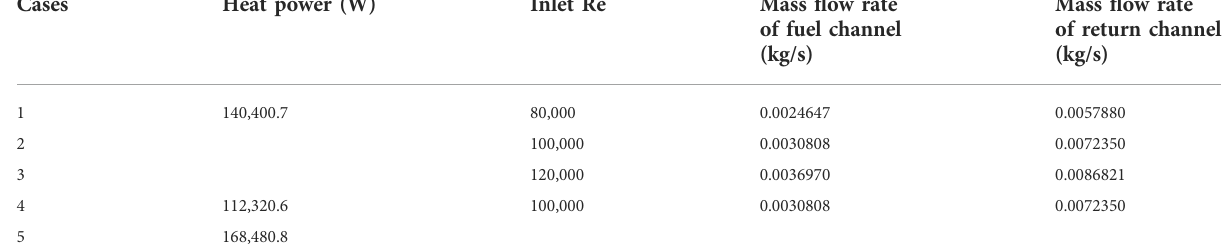
different output powers of components correspond to different fl ow characteristics (i.e., Reynolds number). As a typical case, the inlet Reynolds number of the simulation TABLE 4 Simulation case settings considering different Reynolds numbers and heat power. Cases